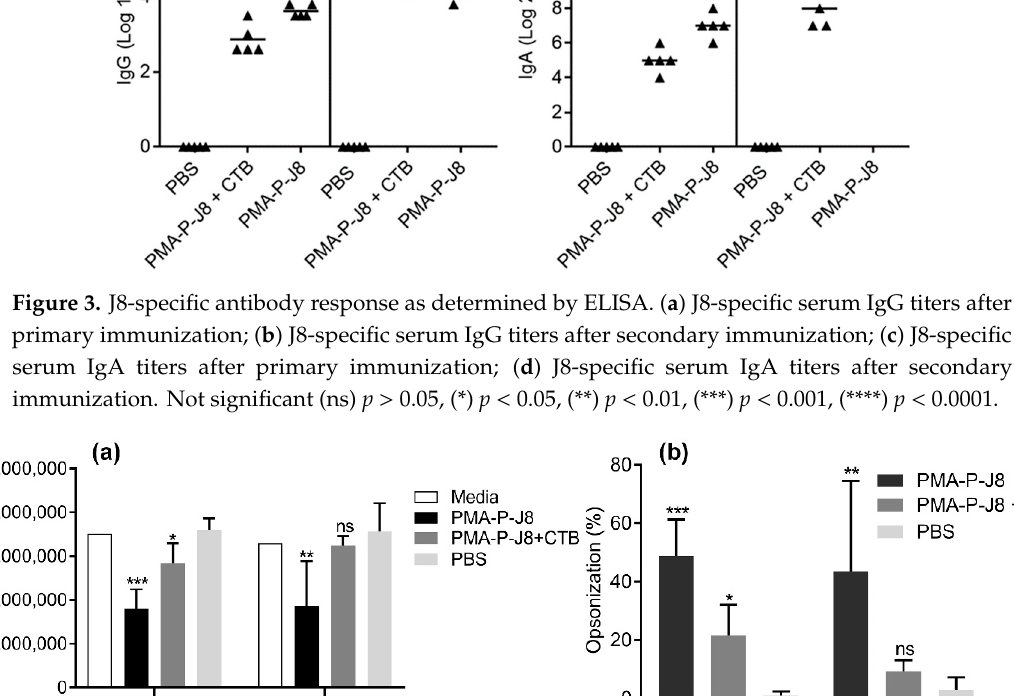
Peptide, Figure S2: Analytical RP-HPLC chromatogram image of PADRE-J8 with alkyne moiety, Rt = 22.9 min, Figure S3: DLS spectra of particle PMA-P-J8 size distributions by intensity.